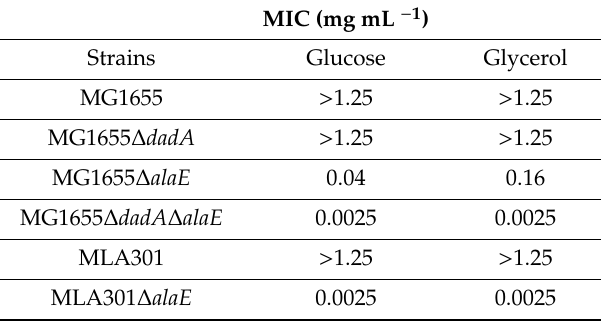
Table 1. MICs (minimum inhibitory concentrations) of L-alanyl-l-alanine in MG1655 and